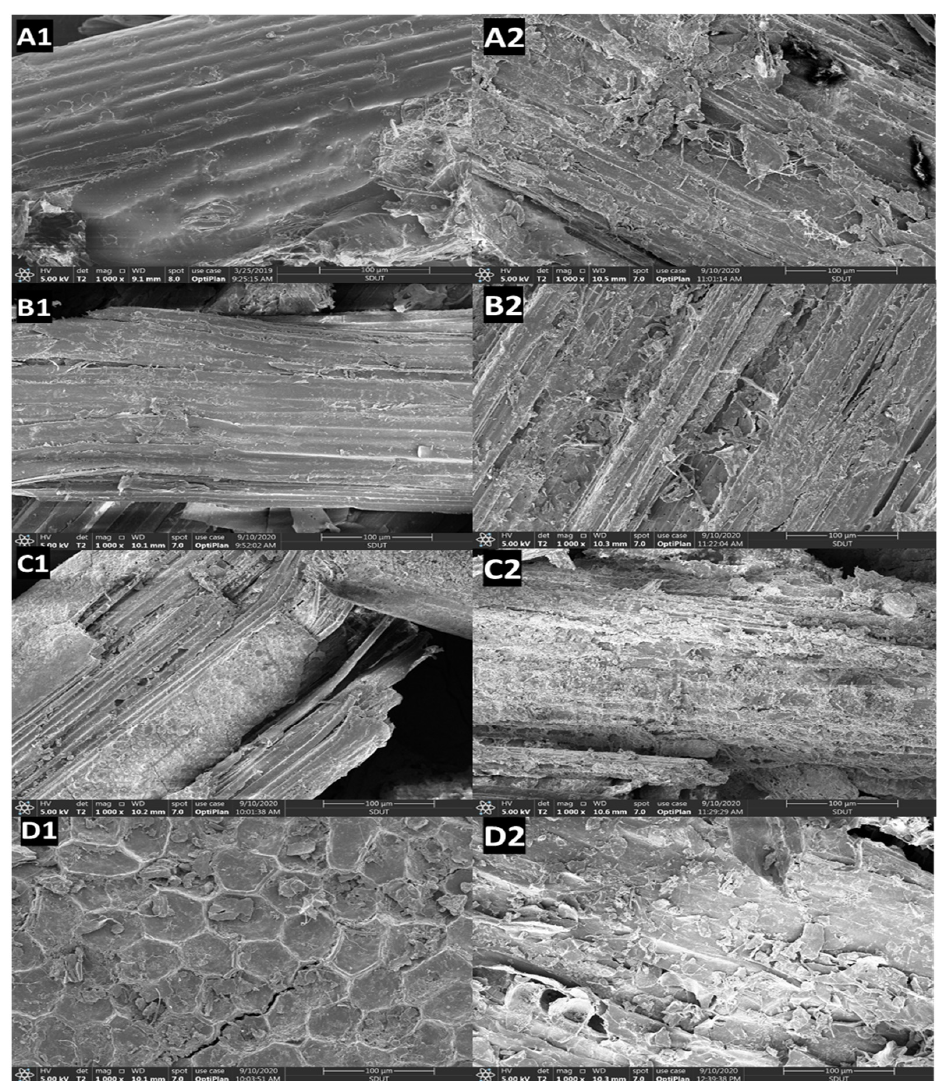
Figure 10. SEM images of SSF cultures: ( A1 ) untreated corn stalk; ( A2 ) C. unicolor SP02 treated corn stalk; ( B1 ) untreated wheat straw; ( B2 ) C. unicolor SP02 treated wheat straw; ( C1 ) C. unicolor SP02 treated rice straw; ( C2 ) C. unicolor SP02 treated rice straw; ( D1 ) untreated pine bark; ( D2 ) C. unicolor SP02 treated pine bark.